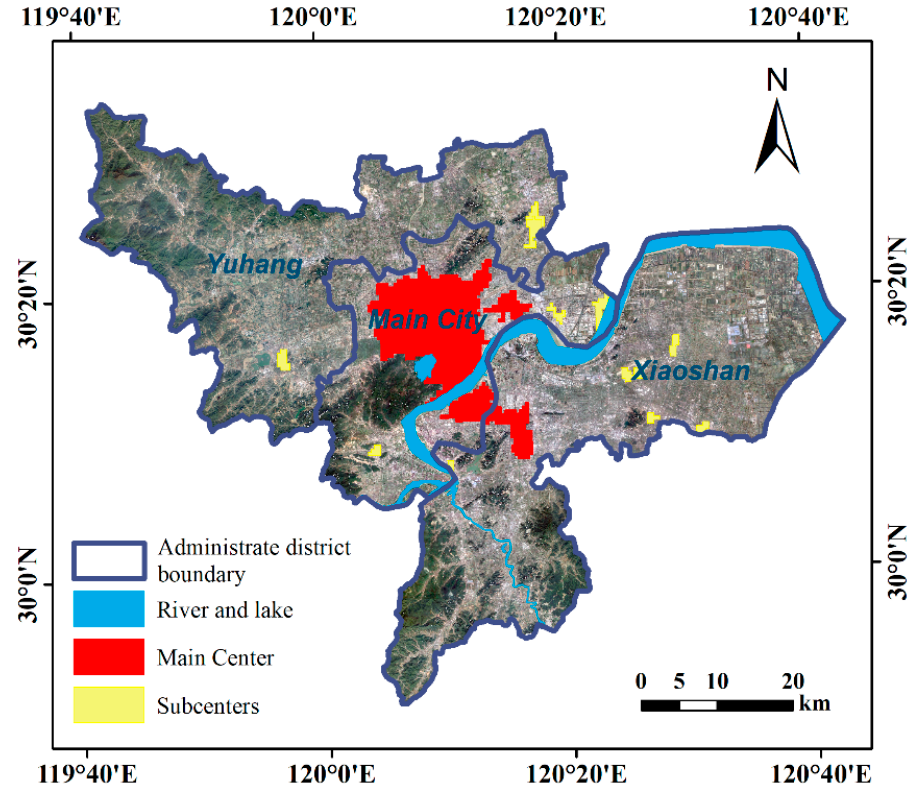
Figure 10. Main centers and subcenters detected by the proposed method. The main centers are shown in red, and the subcenters are shown in yellow . The river and lake layer contains West Lake and the Qiantang River.